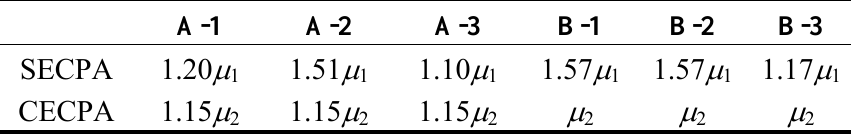
Table 1. Energy consumption per area for different